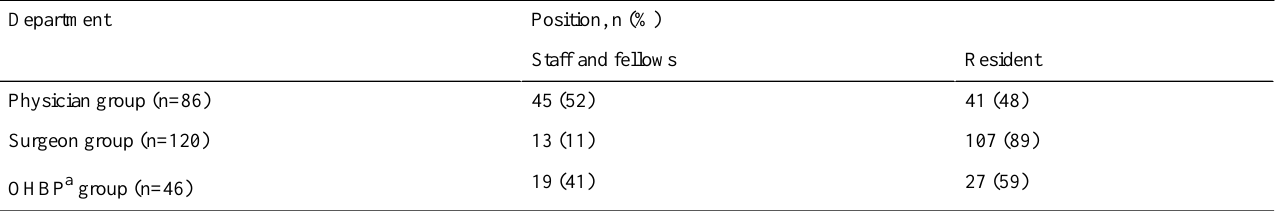
Table 1. Demographics of doctors related to specialty